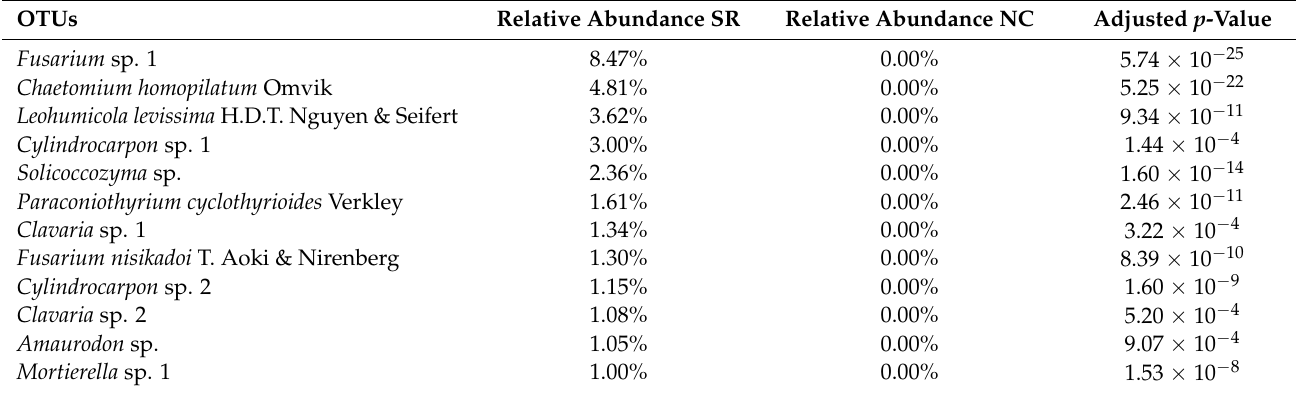
Table 4. List of OTUs with a significantly higher abundance in SR plots compared with NC plots (differential expression analysis based on the negative binomial distribution). The p-values shown are adjusted by false discovery rate (FDR, cut-off at 0.01).